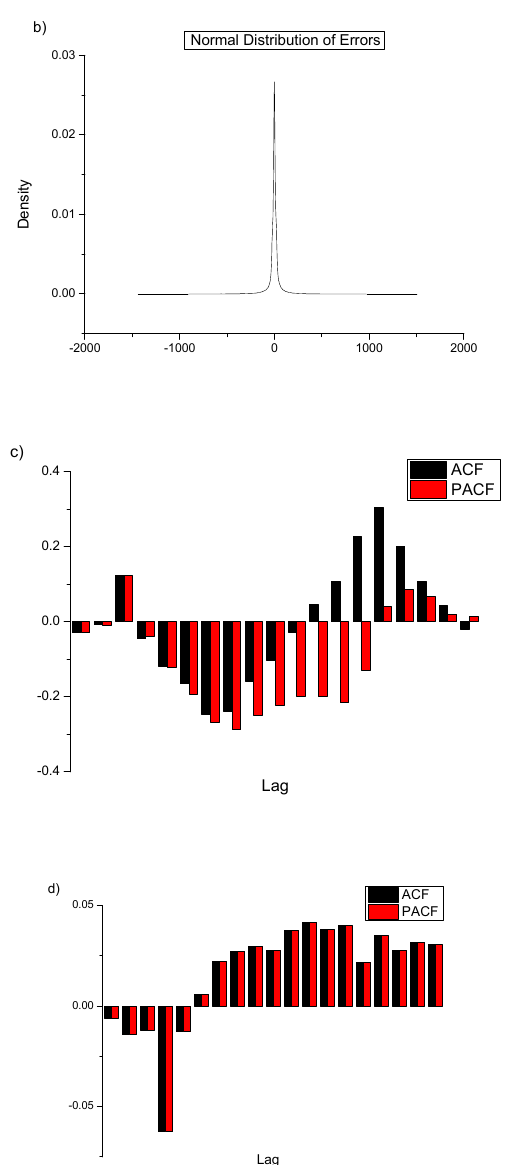
Figure 4. Selecting p , d , q values for the ARIMA model ( a ) 5-min dataset error distribution, ( b ) 60-min dataset error distribution, ( c ) 60-min ACF and PACF plots, ( d ) 5-min ACF and PACF lag.